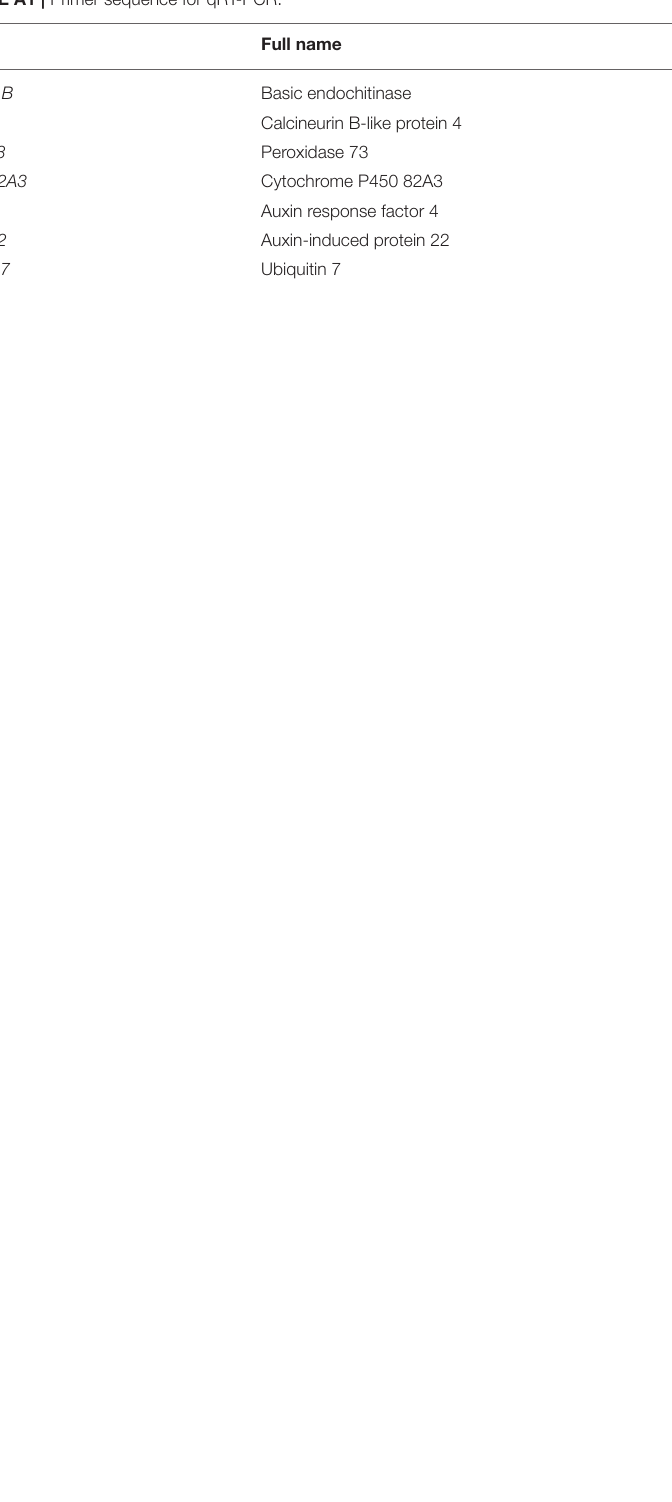
TABLE A1 | Primer sequence for